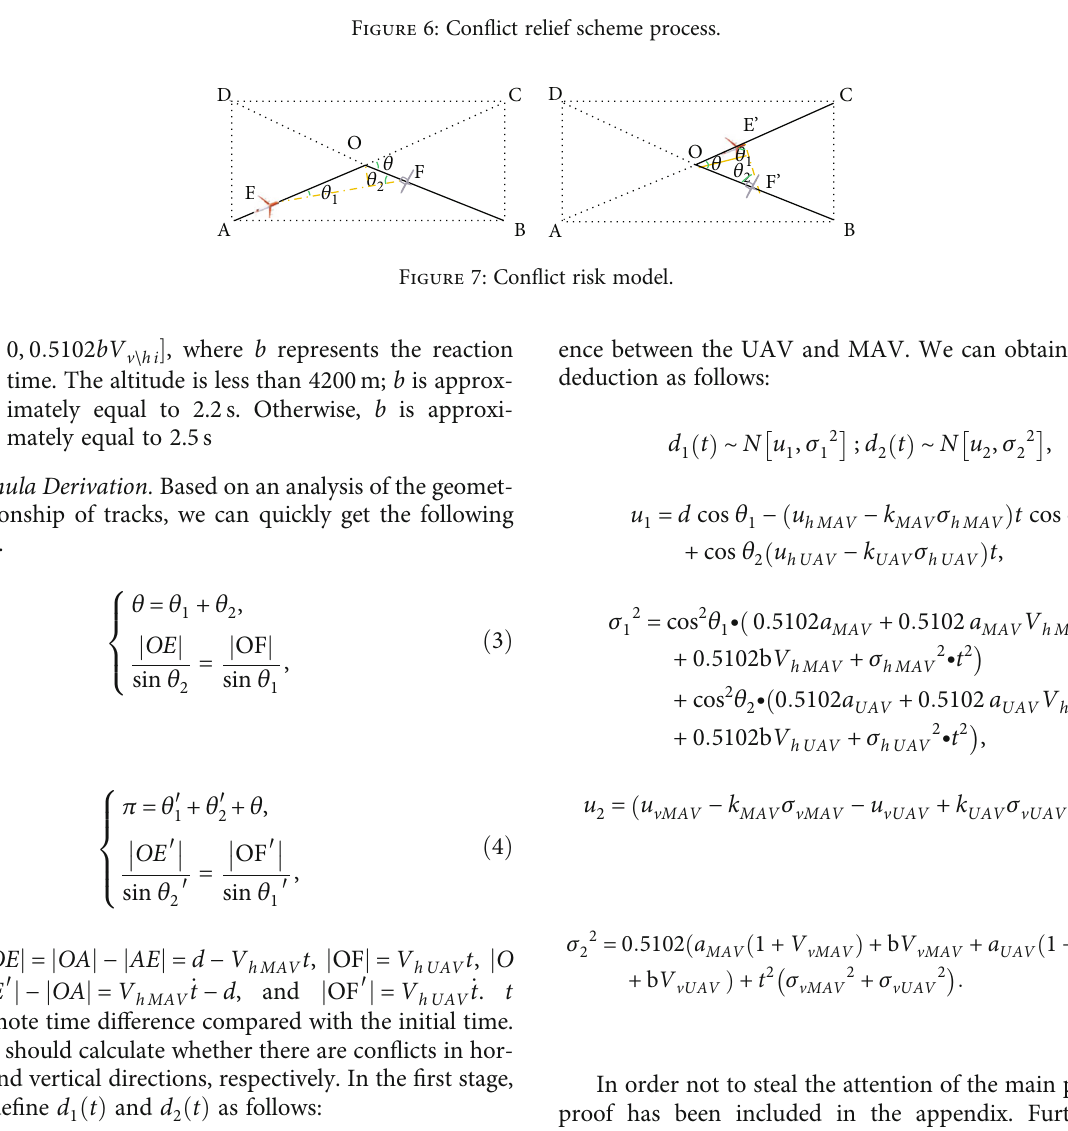
Figure 6: Con fl ict relief scheme process.